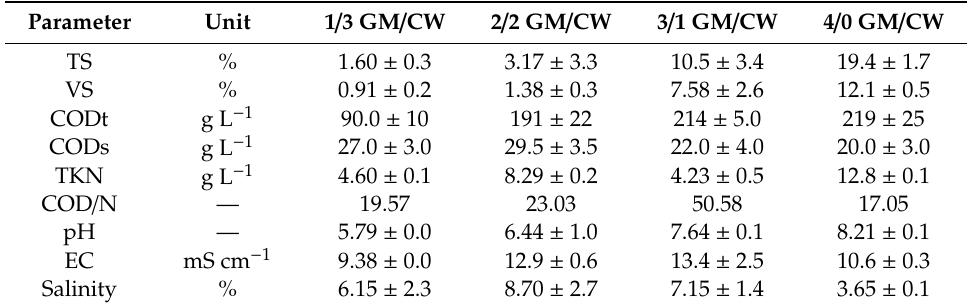
Table 1. E ffl uent characteristics at the completion of the anaerobic treatment. Replicates were configured in a parallel arrangement of grape marc (GM) and cheese whey (CW), on wet weight basis, of